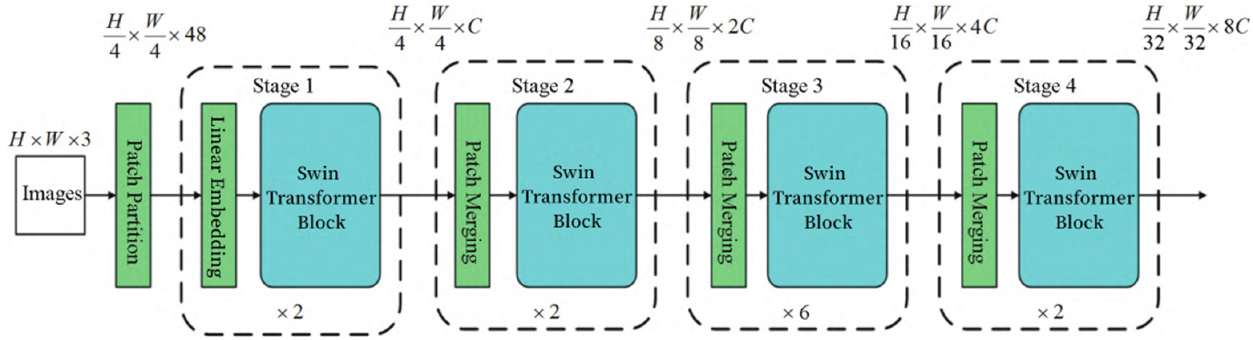
Figure 4. Swin Transformer network